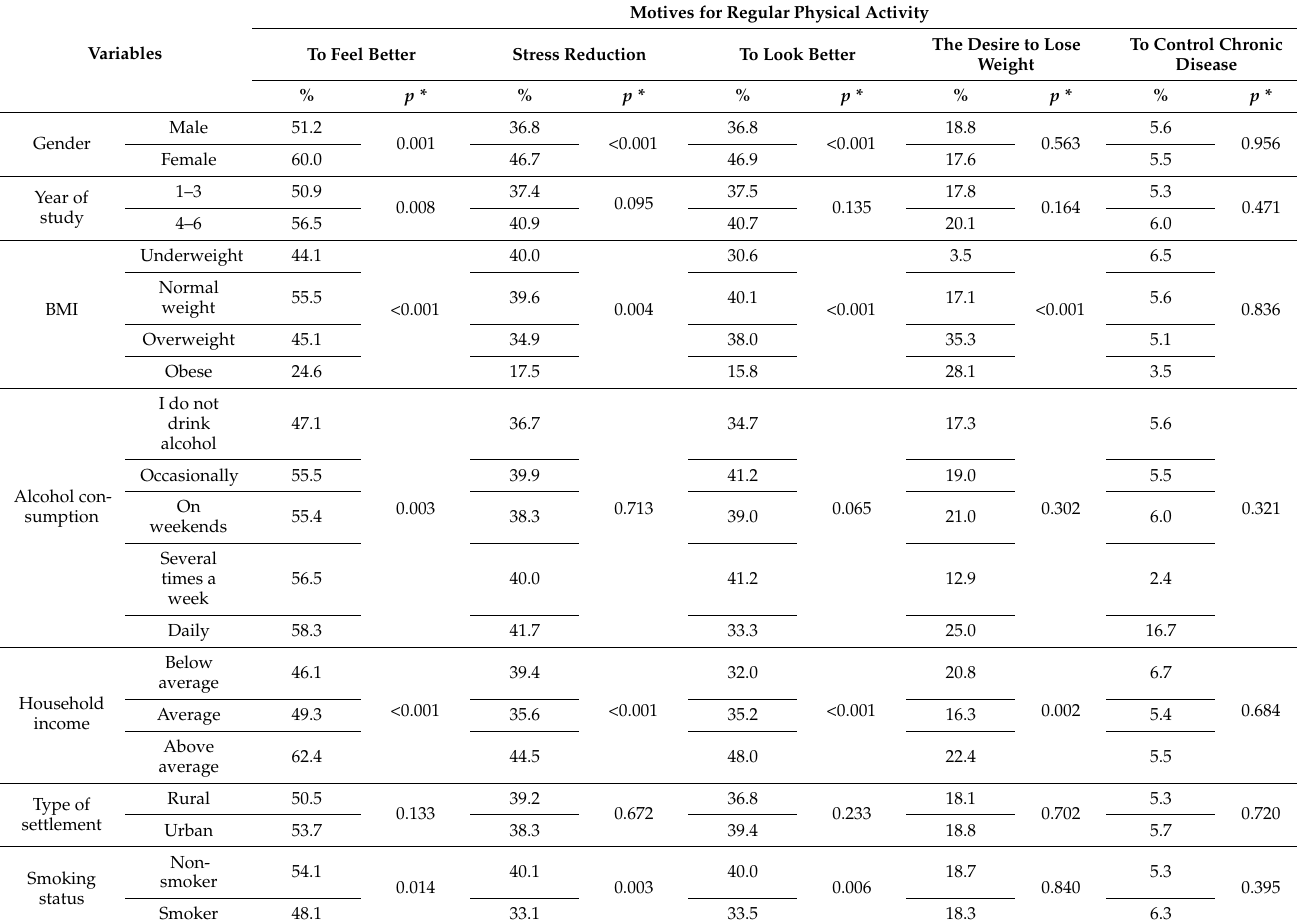
Table 5. Motives for regular physical activity among medical students, according to gender, year of study, body mass index (BMI), alcohol consumption, household income, type of settlement, and student smoking